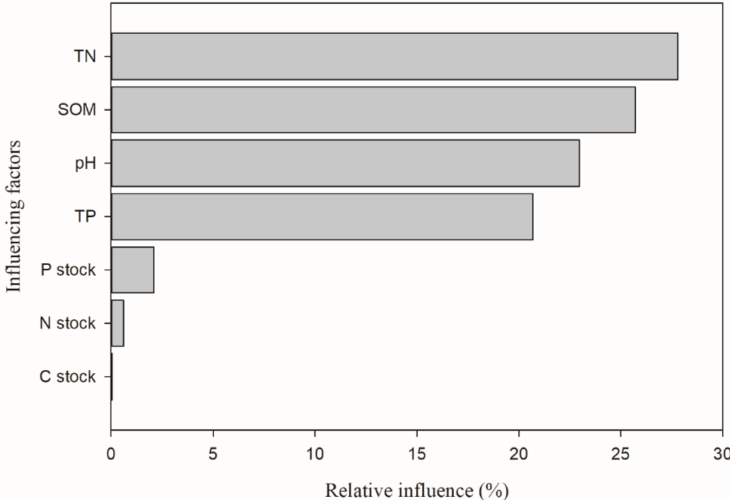
Figure 7. Relative influence (%) of di ff erent predictors on annual crop yield by aggregated boosted tree (ABT) analysis. Long-term data (1983–2016) were used for ABT